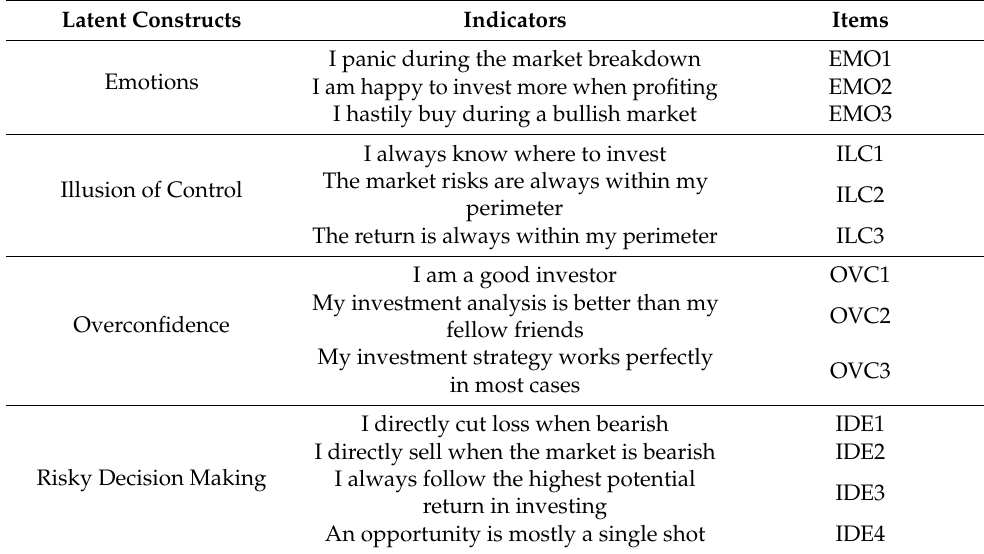
Table 1. Research